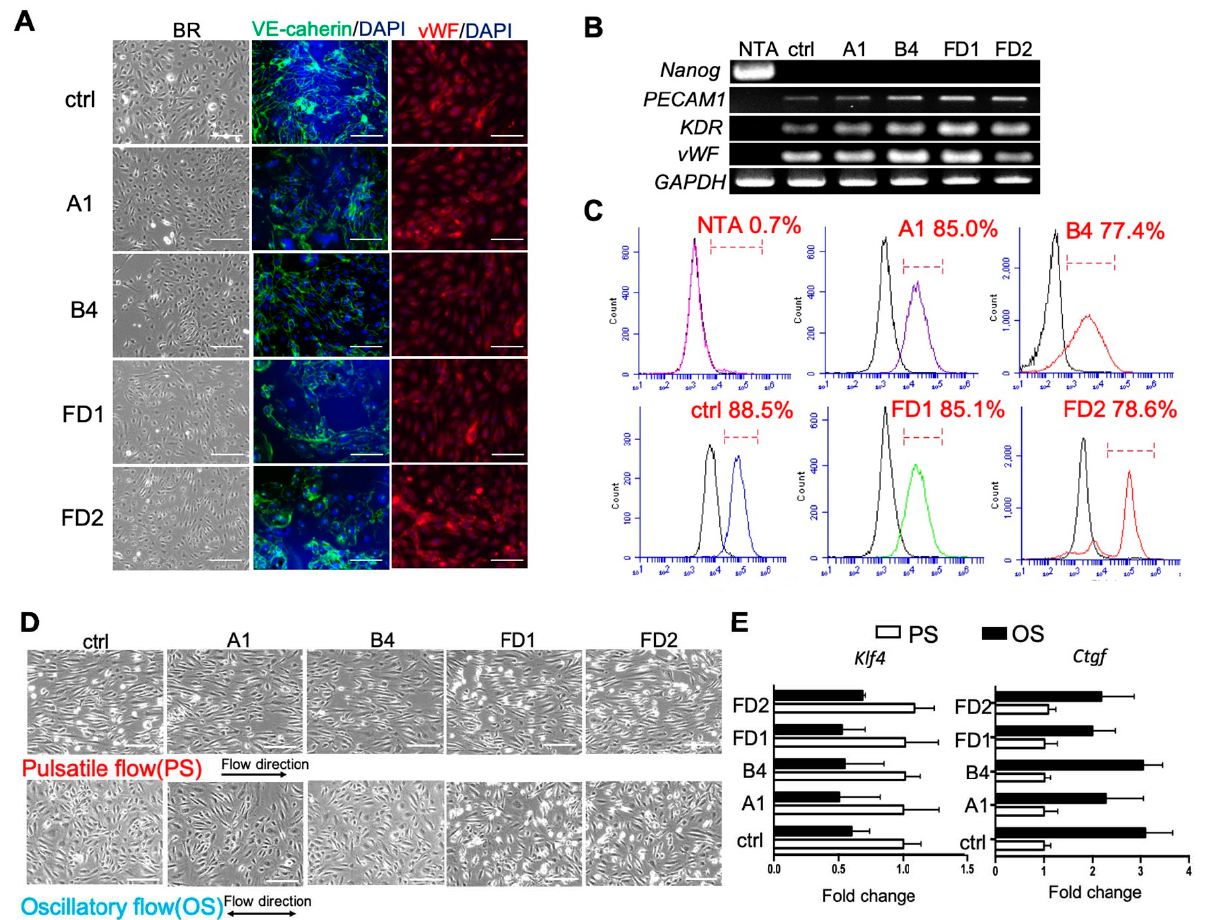
Figure 2. Characterization of the ECs differentiated from corrected FD-iPSCs and FD-iPSCs. ( A ) Characterizations of ECs of corrected FD-iPSCs and FD-iPSCs by phase contrast microscopy and immunostaining. The cells were stained with endothelium markers VE-cadherin and vWF. HUVECs were used as positive control (ctrl). The scale bar is 100 µ m. n = 4 images from 4 biological replicates. ( B ) RT-PCR for endothelial markers ( PECAM1 , KDF , and vWF ), and pluripotent marker ( Nanog , negative control), for ECs after 30 days of differentiation. HUVECs were used as a control for normal GLA genome (ctrl). NTA is normal hiPSCs which served as control for pluripotency. n = 4 images from 4 biological replicates. ( C ) Histogram analyses of CD31 in corrected FD-ECs, FD-ECs, and HUVECs by FACS. n = 4 images from 4 biological replicates. ( D ) Morphological regulation of corrected FD-ECs and FD-ECs after 24 h of pulsatile shear stress (PS) and oscillatory shear stress (OS). The arrow indicates direction of flow. n = 4 images from 4 biological replicates. ( E ) Relative changes of klf4 and Ctgf in corrected FD-ECs and FD-ECs after 24 h of PS and OS. The scale bar is 100 µ m. The error bars represent